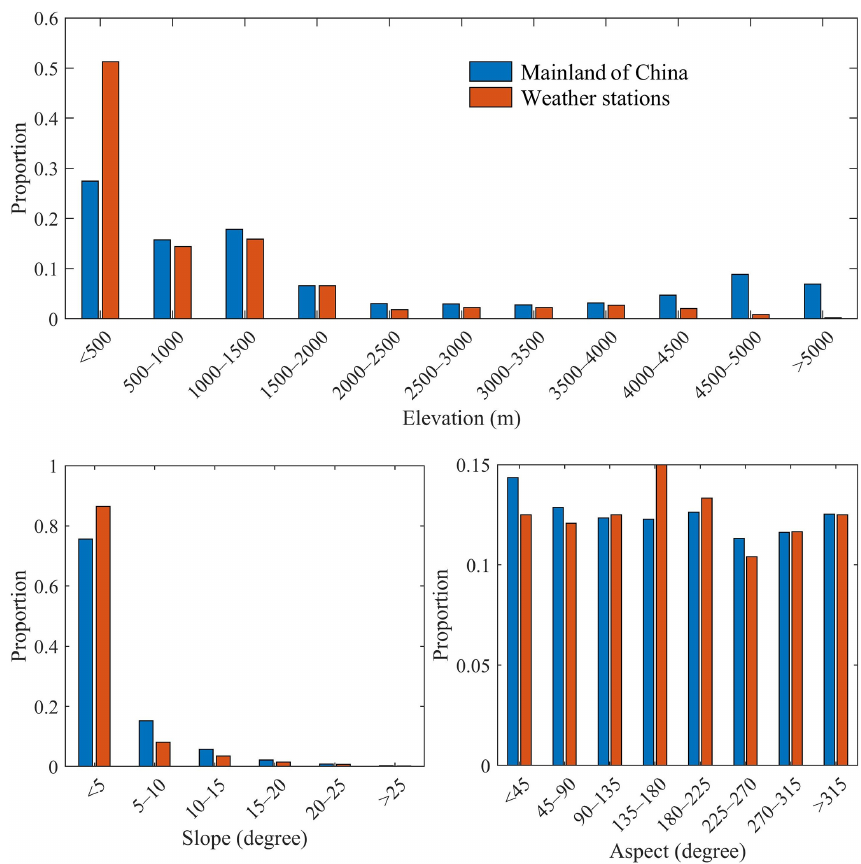
Figure 2. Orographic statistical information at different gradients for China and weather stations used in this